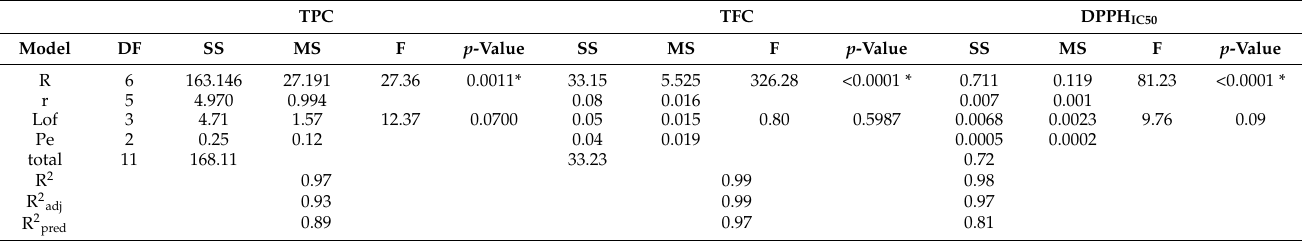
Table 3. The analysis of variance (ANOVA) of studied fitted